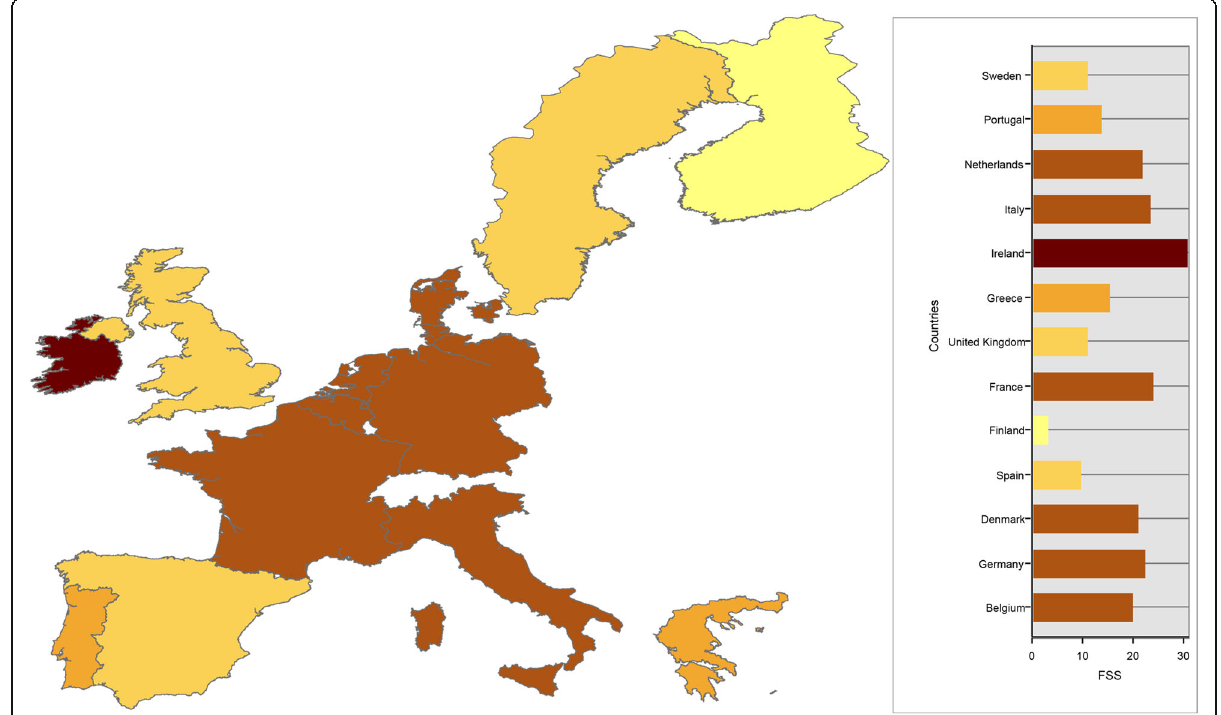
Fig. 7 The weighting of FSS Code deficiencies as a result of AHP